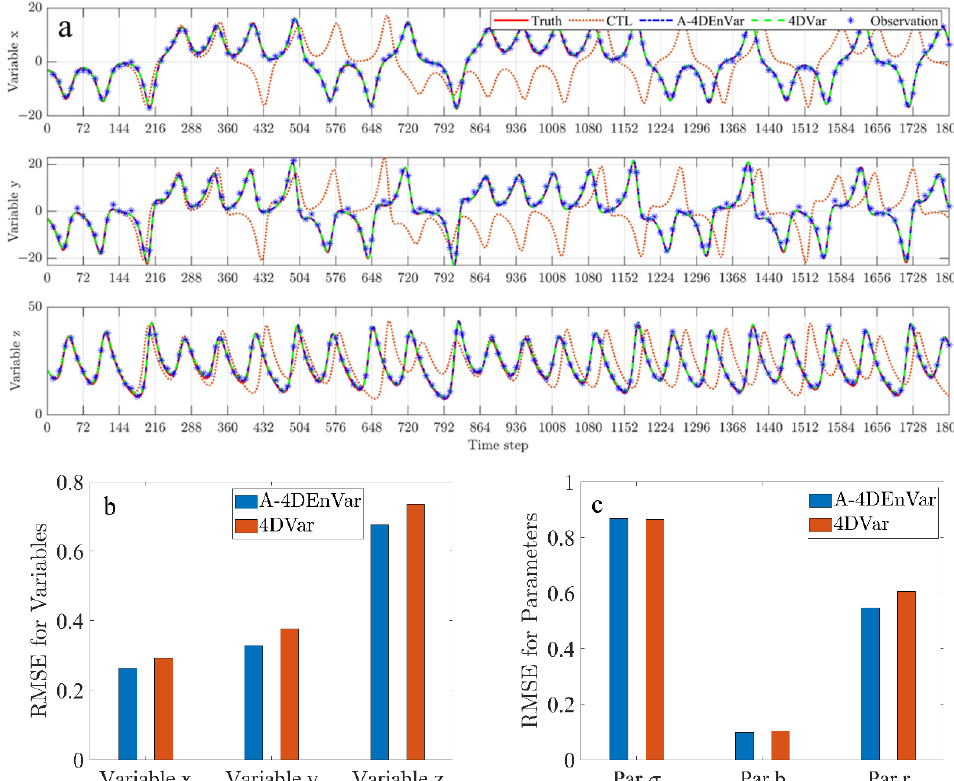
Figure 2. ( a ) The solutions of the truth, model control run, data assimilation results from A-4DEnVar, and conventional 4DVar schemes in the first 25 windows. ( b ) The RMSE of state variables for 200 windows and ( c ) parameters for A-4DEnVar and 4DVar algorithm for 200 windows, respectively. The usage of factor µ to control the value of perturbations and generate ensemble members is an important difference between A-4DEnVar and 4DEnVar methods. Figure 3 shows the difference between the gradients (in the first iteration step) calculated by A- 4DEnVar and the traditional 4DVar method with the change of µ . It is shown that, in Lorenz-63 model, only if the factor is less than 10 − 6 which is far less than the value of the background error covariance used in other 4DEnVar methods, the gradients (for both variables and parameters) obtained from A-4DEnVar are close enough to that from traditional 4DVar.